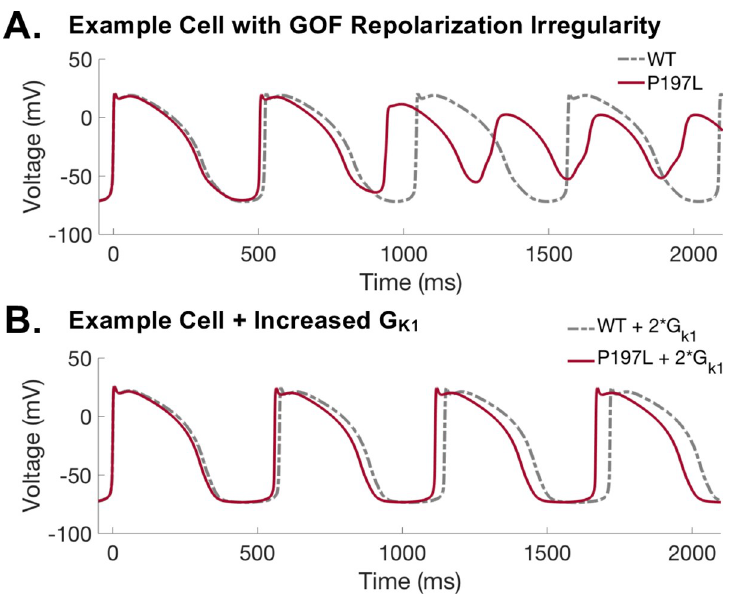
Fig 7. Example of repolarization irregularity in gain of function (GOF) mutant. (A) Sample action potential showing repolarization irregularity in P197L mutant, a GOF mutation, compared to wild-type. (B) Stabilization resting potential by increased in G K1 . GOF mutant causes expected shortening of AP duration, and increase in G K1 prevents repolarization